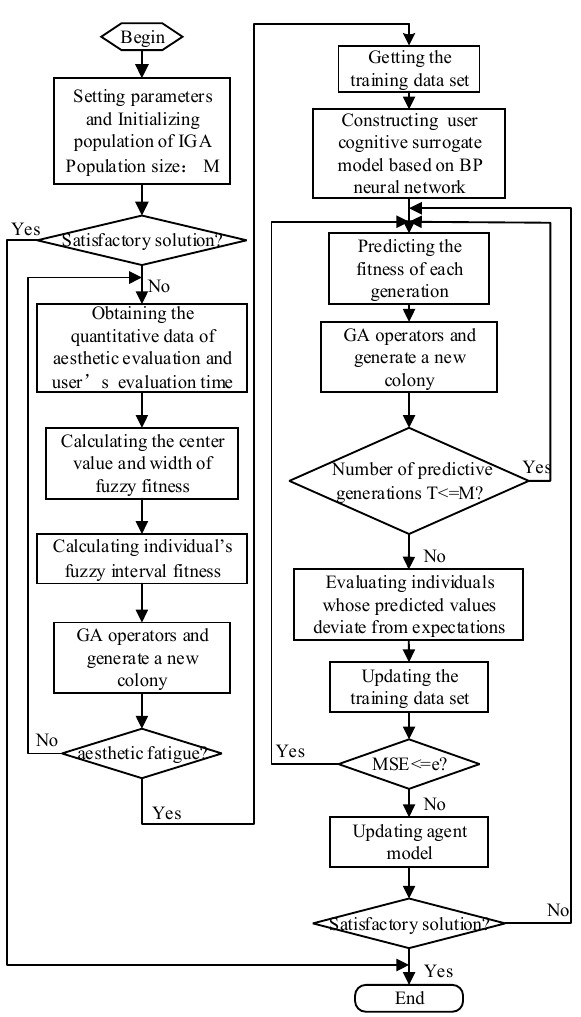
Figure 1. The algorithm process.